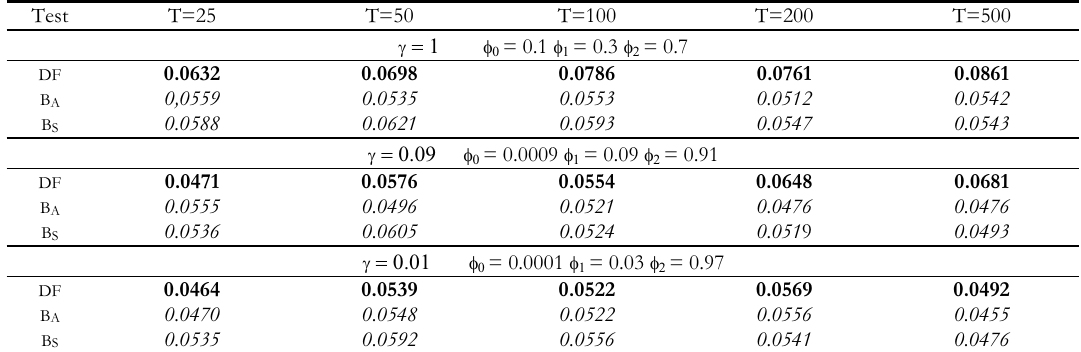
Proporzione di rigetti nell’ipotesi nulla (cid:68) =1 su N=10.000 serie